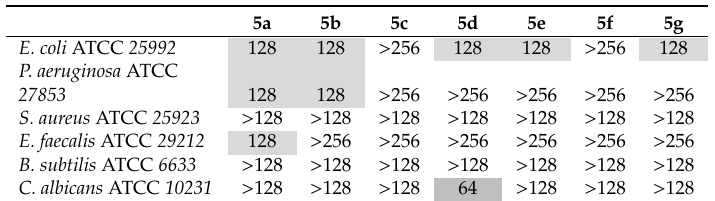
Table 2. The inhibitory activity of the new F-compounds 5a – g on the planktonic growth of the tested microbial strains. The minimum inhibitory concentration (MIC) expressed in µ g / mL of the new fluoro compounds ( 5a – g ) are presented as the average of three di ff erent experiments. The most active compounds are